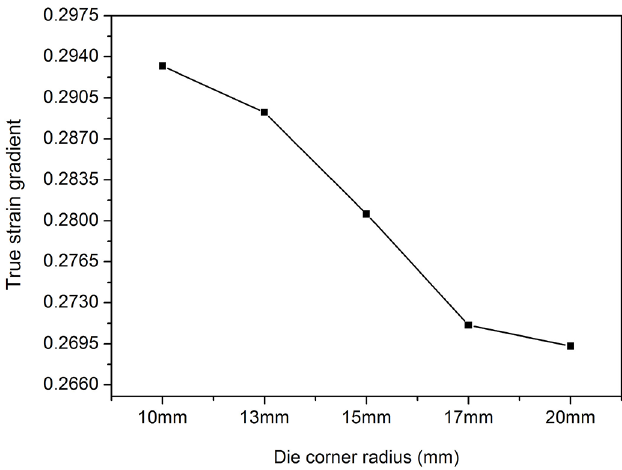
Fig. 13. True strain gradients between the external and the internal surface at the cup wall of square cups under various die corner